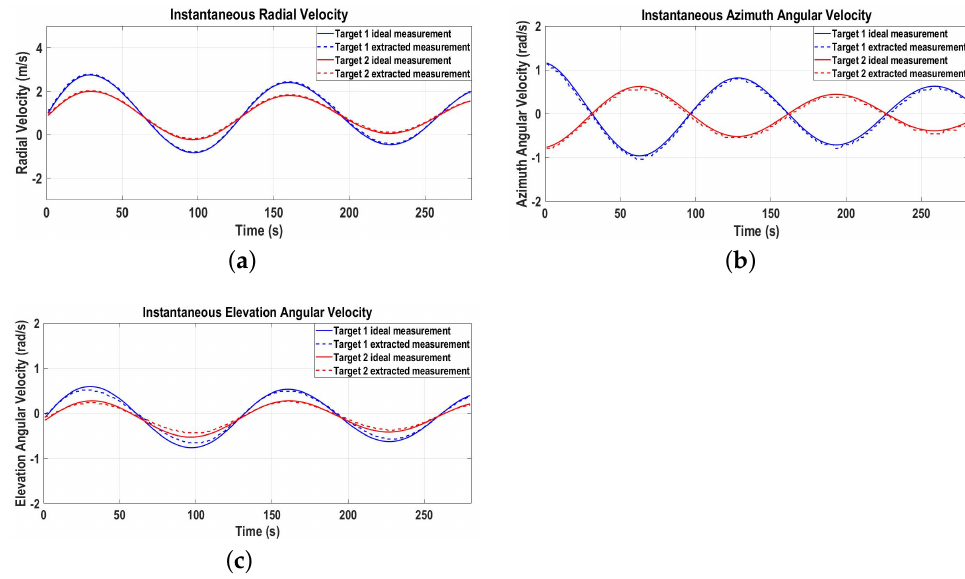
Figure 5. Three-dimensional velocity measurements for Scenario 1. ( a ) Radial velocity measurement; ( b ) Azimuth angular velocity measurement; ( c ) Elevation angular velocity